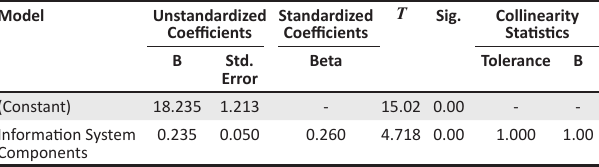
TABLE 3: Pearson coefficients. Model